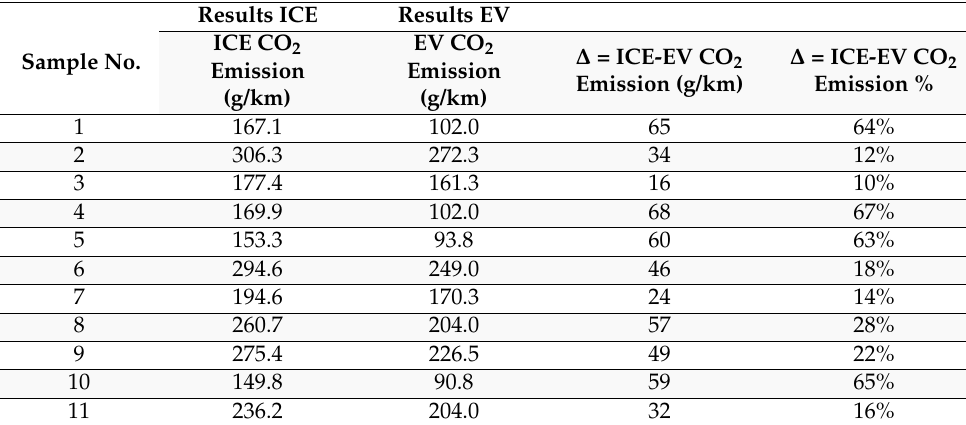
Table 4. Comparison of the CO 2 emission values of the tested vehicles. Results Sample No.